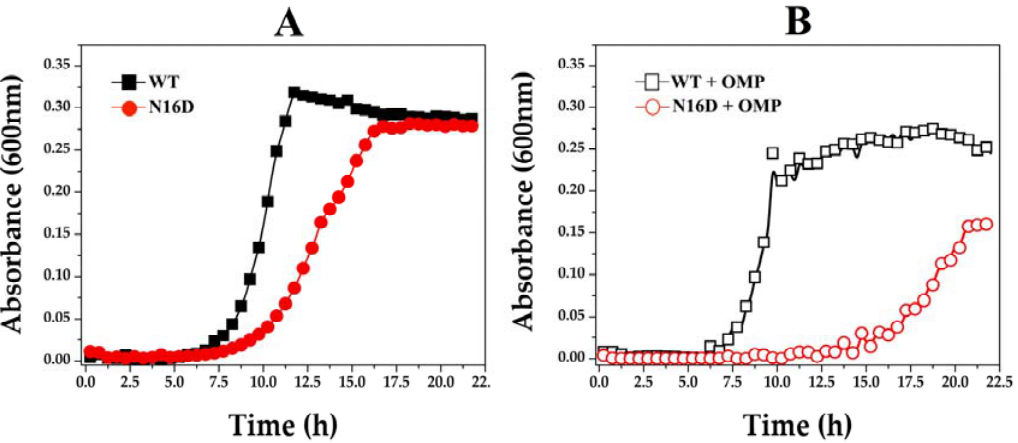
Figure 5. Growth curves of E. coli Δ tim complemented with WT and N16D Hstim genes. The E. coli strain Δ tim BL21 ‐ Gold(DE3) was transformed with the overexpression plasmid pET ‐ 3a HisTEV, encoding either WT or N16D HsTIM. In A , the growth of cells supplemented with WT (filled black squares) and N16D (filled red circles) HsTIM in the absence of omeprazole is shown. In B , the growth of cells supplemented with WT (open black squares) and N16D (open red circles) HsTIM in the presence of 0.75 mM omeprazole is shown. The optical density (OD600) was plotted against the incubation time (h) in M9 minimal medium supplemented at 37 °C. The assays were performed in quadruplicate on a Synergy MX microplate reader on 96 ‐ well plates.